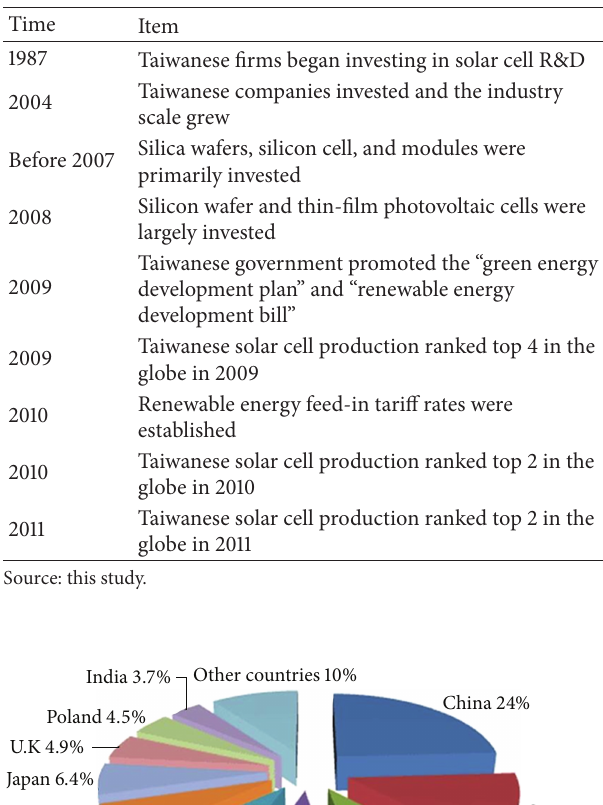
Table 3: The history of Taiwanese solar photovoltaic industry